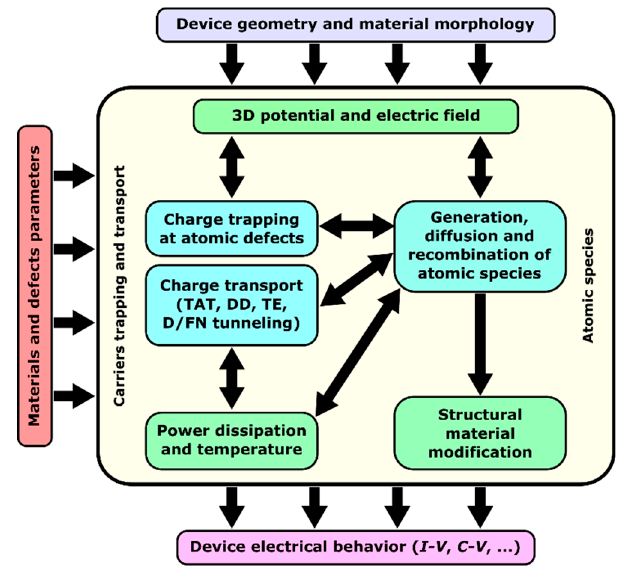
Figure 2. Multiscale modeling platform for RRAM devices. The device-level simulation engine includes three main modules: one for the simulation of charge transport; one for charge trapping; and one for the simulation of atomic species generation, diffusion, and recombination. The simulation requires the material parameters, calculated using ab-initio methods, and a definition of the device geometry. The modeling platform considers the 3D potential and electric field and how they are affected by localized trapped charge and power dissipation at defects. The results are the various characteristic curves describing the device electrical response.